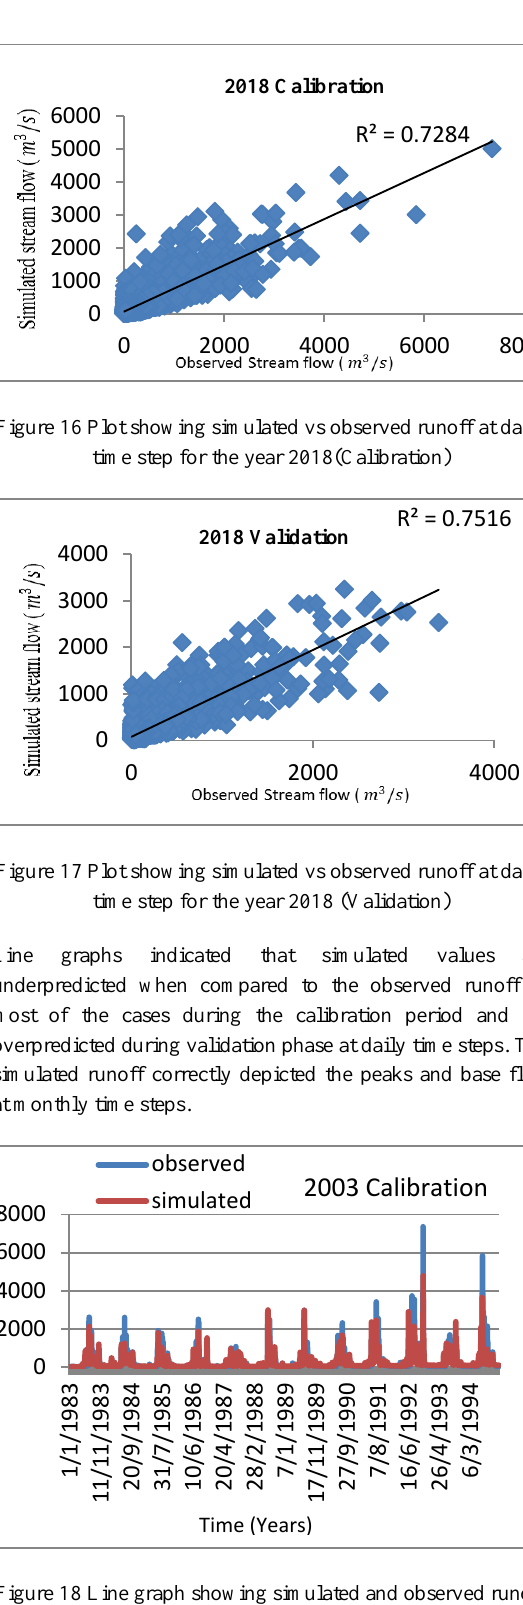
Figure 18 Line graph showing simulated and observed runoff vs time at daily time step for the year 2003 (calibration)